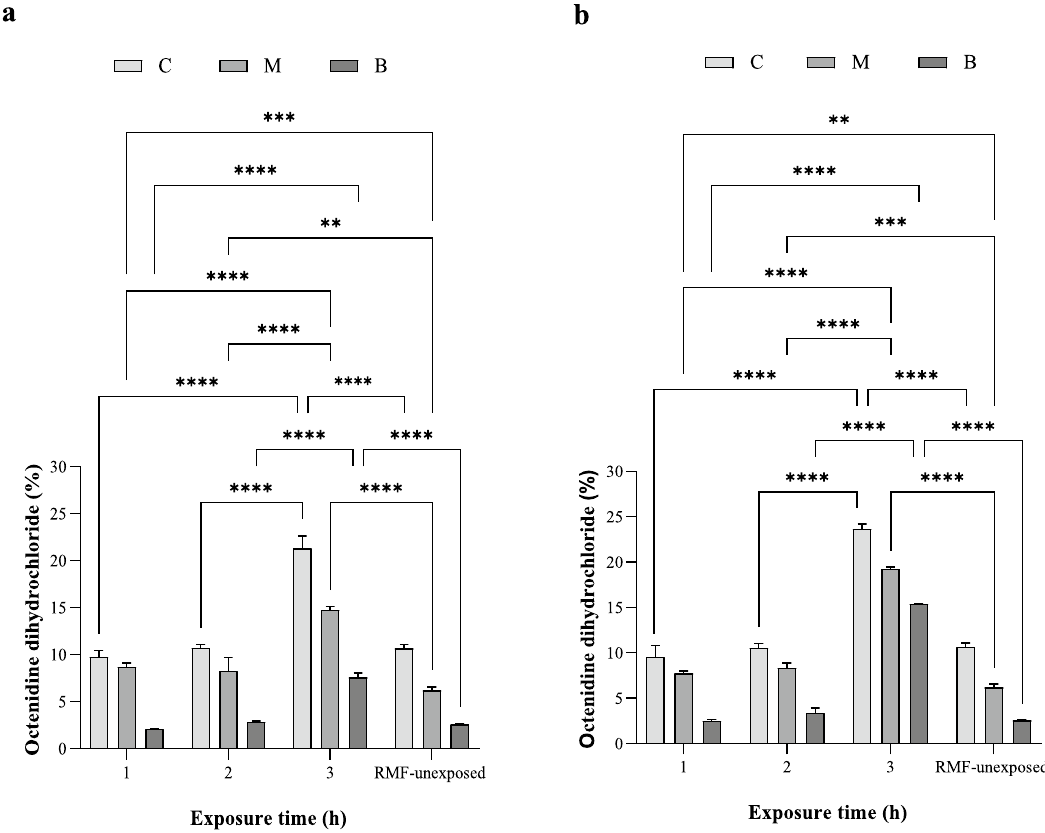
Figure 6. Percent of octenidine dihydrochloride extracted from successive agar discs exposed to RMF of ( a ) 5 Hz and ( b ) 50 Hz, in comparison to its initial concentration in the carrier. The results are presented as mean ± SEM. The asterisks in graphs indicate statistically significant differences between RMF-exposed and RMF-unexposed agar discs (* p < 0.05, ** p < 0.01, *** p < 0.001, **** p <